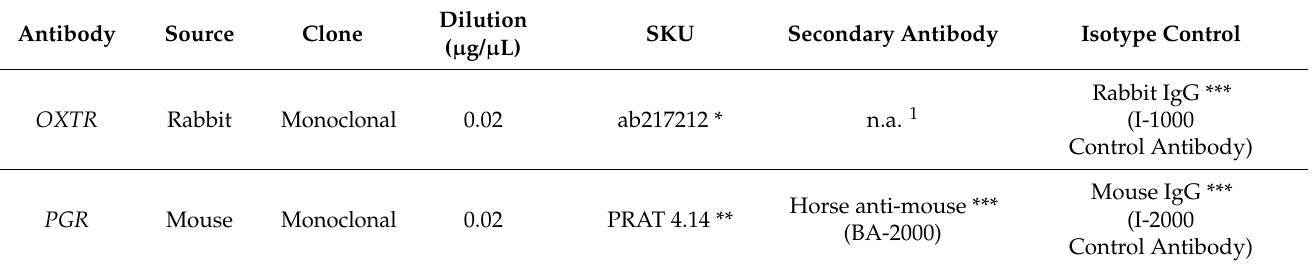
Table 2. Overview of primary and secondary antibodies used for IHC. Stock Keeping Unit (SKU) and producer given (* Abcam, Cambridge, UK; ** Thermo Fisher Scientific, Waltham, MA, USA; *** Vector Laboratories Burlingame, CA,